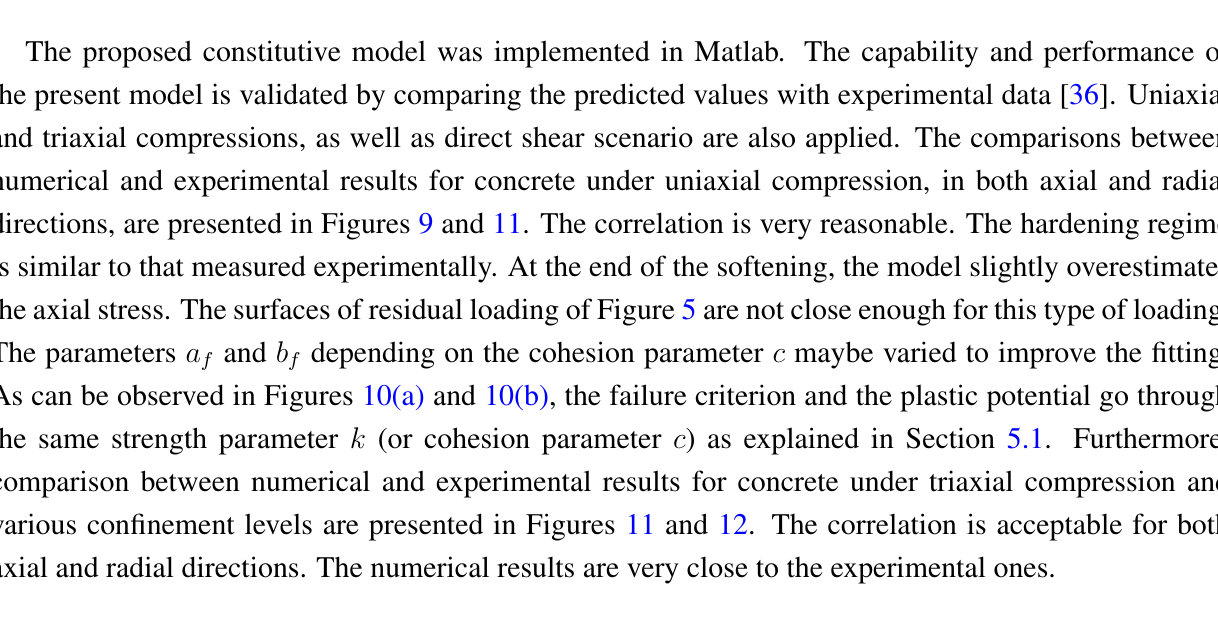
Figure 10. Hardening and softening stages in uniaxial compression test. ( a ) Hardening; ( b )